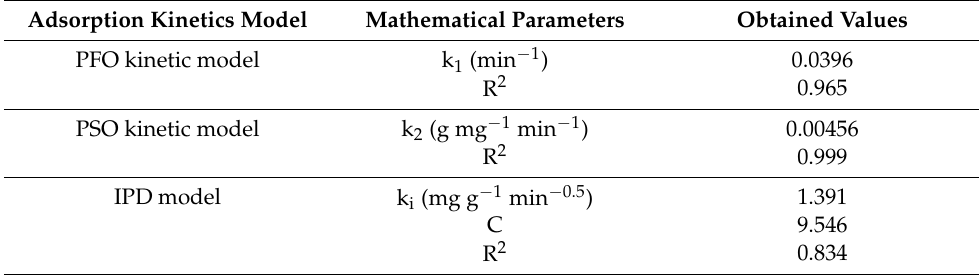
Table 1. Kinetic Parameters for RO 16 dye